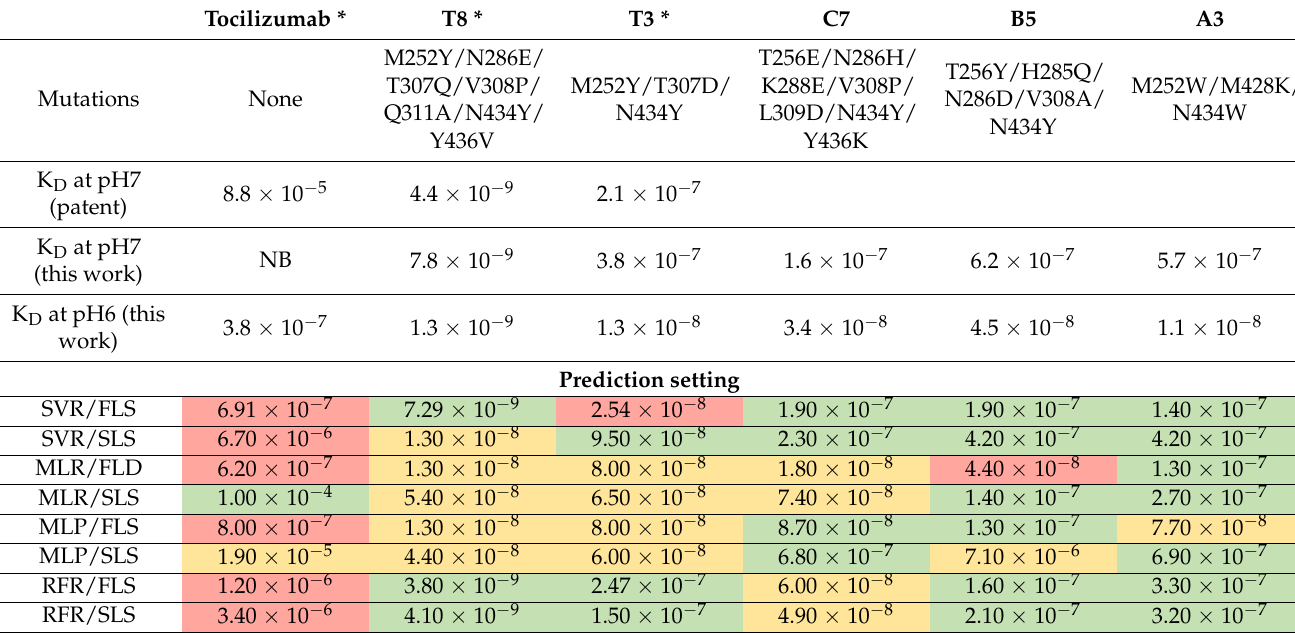
Table 2. Comparison of predicted versus experimental affinities at pH 7.0 for 3 randomly generated variants. The 3 variants have 3, 5, and 7 mutations and are predicted with the two different models and with 4 different algorithms. Measured affinities at pH 6.0 are also shown. Cells in green, yellow, and red correspond to very good (log err = |log(pred) − log(K D )| ≤ 0.1), correct (0.1 < log err ≤ 1), and incorrect (log err > 1) predictions, respectively. Statistical analysis is given in Table 3.